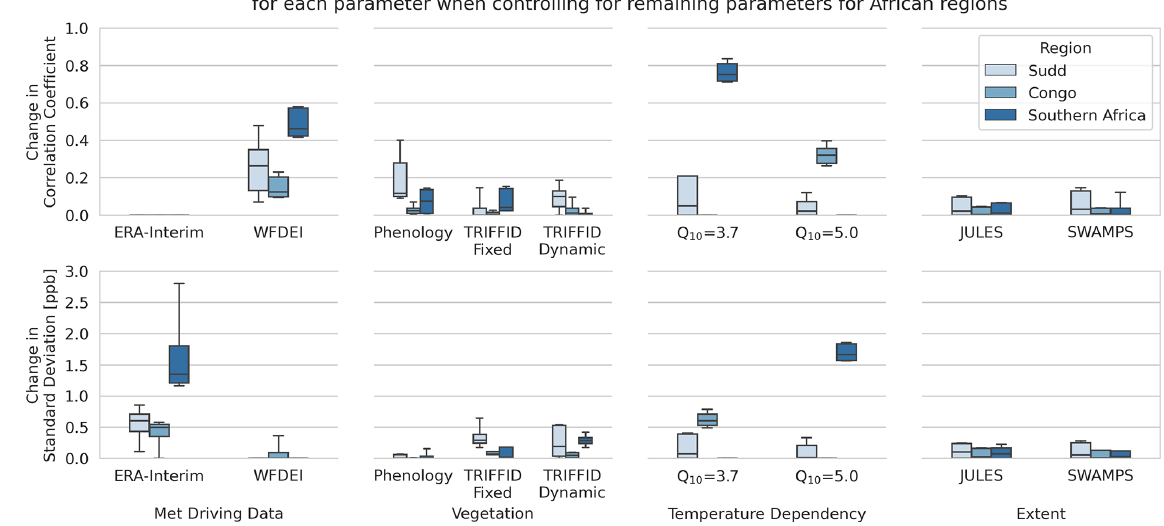
Figure 7. The change in correlation coefficient (top) and standard deviation (bottom) between the JULES ensemble and GOSAT wetland CH 4 seasonal cycle when controlling for the remaining ensemble parameters. The change is the difference above the minimum value for each set of ensemble members. An increased correlation coefficient should be considered an improvement, whereas an increased standard deviation should be considered a deterioration. The figure shows the changes for the three wetland regions that we examine over Africa (Sudd, Congo and Southern Africa) and are presented as box-and-whisker plots (box: quartiles; whiskers: